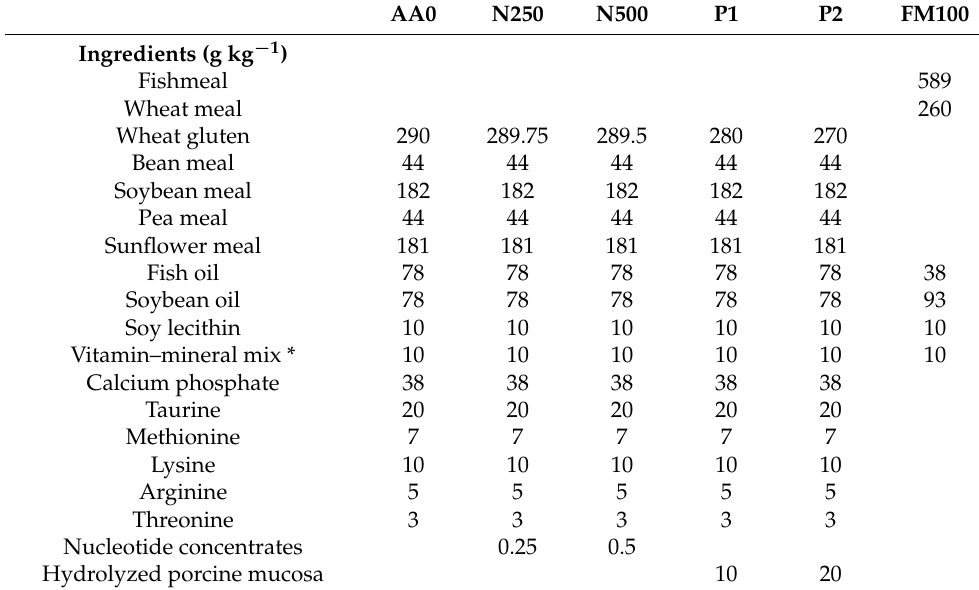
Table 1. Formulation of experimental diets.